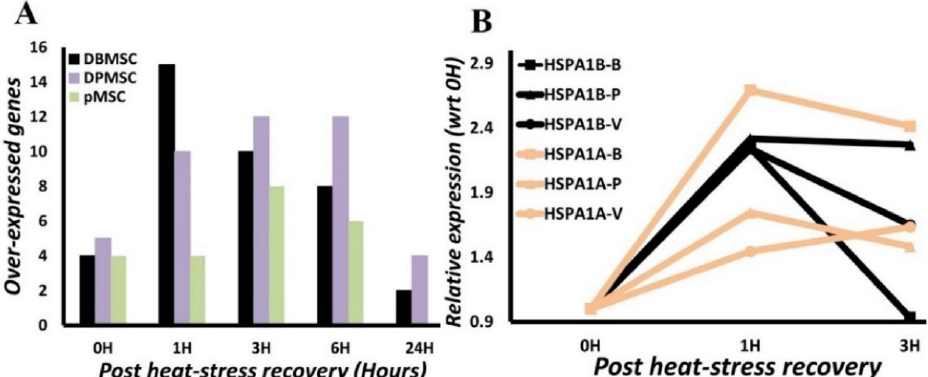
Figure 6. ( A ) Number of over-expressed genes. Number of genes overexpressed immediately at conclusion of heat stress (0H) and during recovery at 37 °C at 1 h (1H), 3 h (3H), 6 h (6H), and 24 h (24H). Minimum variation in number of overexpressed genes is seen at 0H with 4–5 genes overexpressed across the three stem cell types. ( B ) Variation of HSPA1A and HSPA1B gene expression in ‘post heat-stress recovery phase’. Less-that-3-fold change in gene expression with respect to expression after heat-stress exposure, i.e., 0H. B in the label represents DBMSCs, P represents DPMSCs, and V represents pMSC.